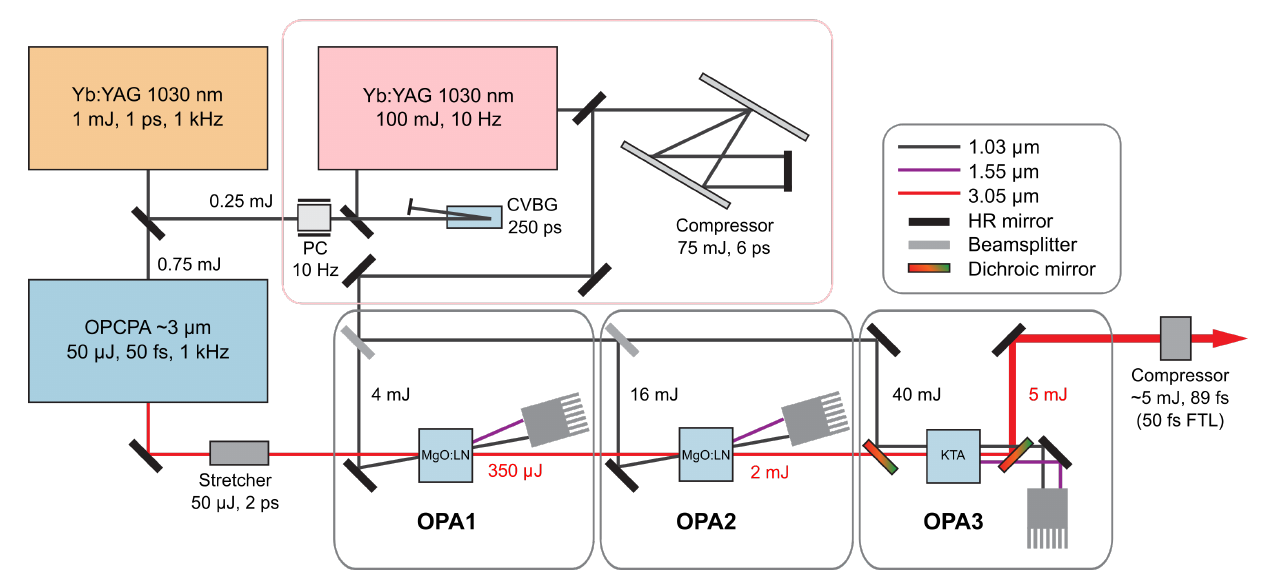
Figure 8. Overall schematic of a 5 mJ, 5-optical-cycles, 3 µm mid-IR OPCPA laser